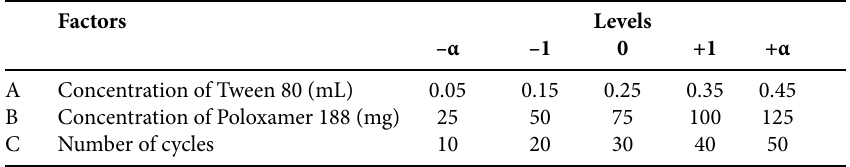
Table 2. Central Composite Design with factors and their responses